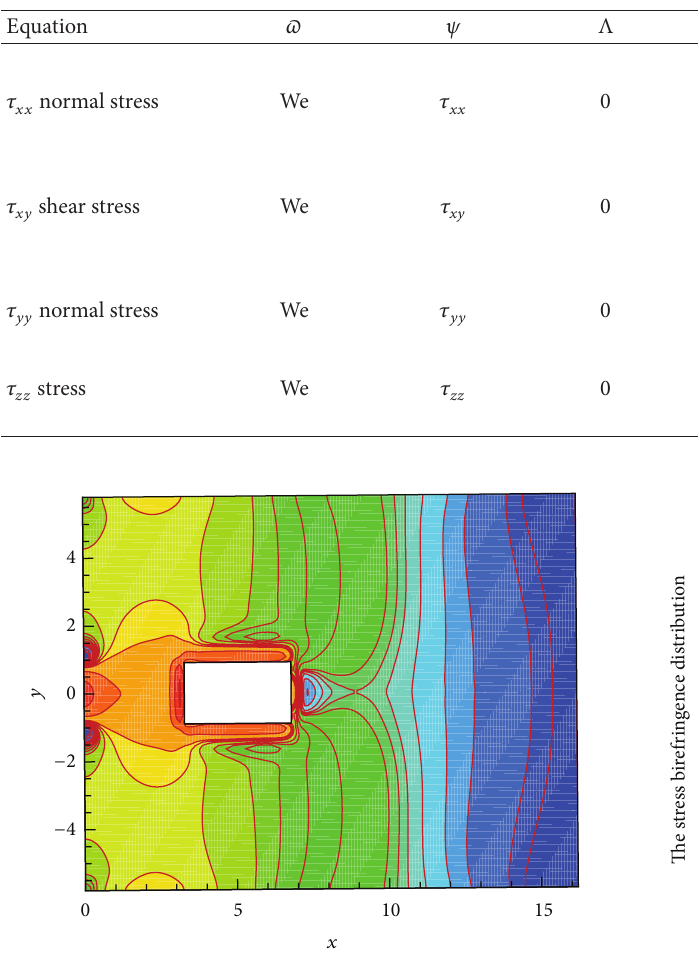
Table 1: Definition of the constants and functions in the constitutive equation [24, 25].